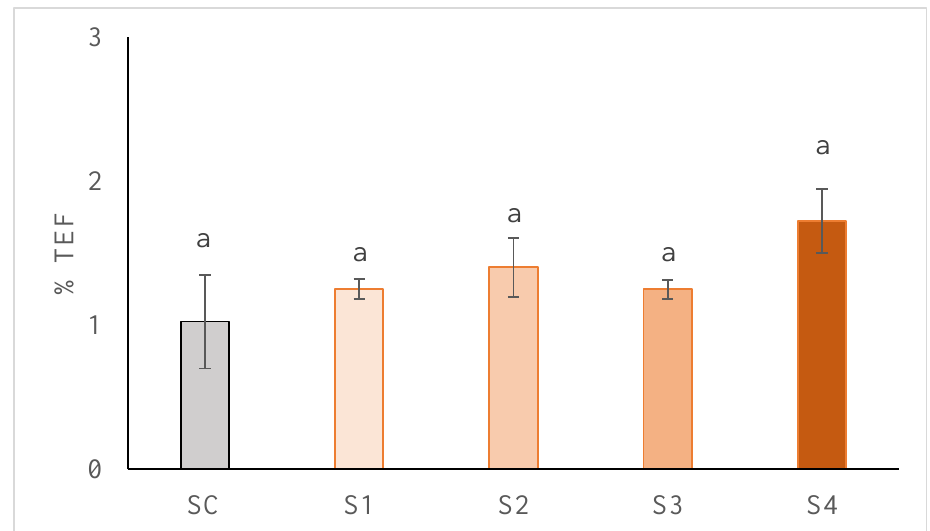
Figure 1. Effect of partial and total replacement of pork back fat by GE, from hemp oil and buckwheat flour, on emulsion stability of frankfurters. Results are expressed as % total expressible fluid (%TEF). SC: frankfurter without GE; S1: frankfurter formulated with GE as 25% fat replacer; S2: frankfurter formulated with GE as 50% fat replacer; S3: frankfurter formulated with GE as 75% fat replacer, and S4: frankfurter formulated with GE as 100% fat replacer. For each parameter, results followed by the same case letter are not significantly different according to Tukey’s HSD post-hoc test ( p > 0.05). Data are presented as the mean values of replications ± SD.